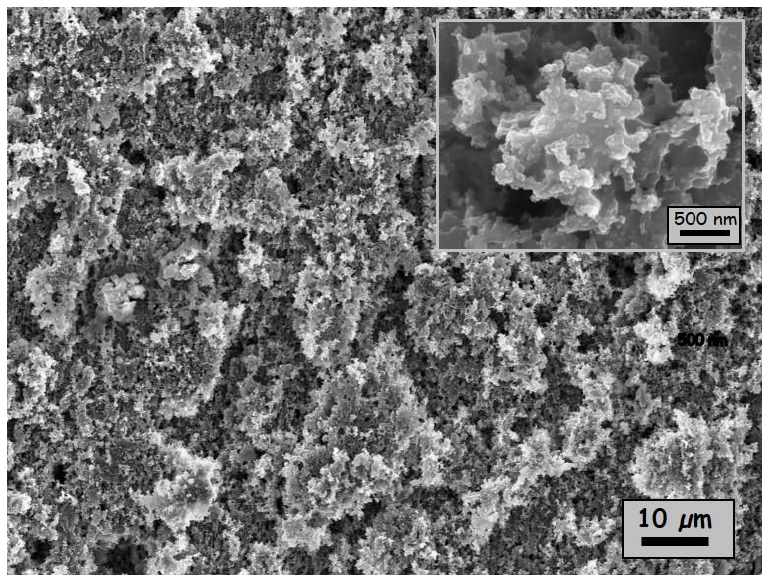
Figure 4. FESEM image of TiO 2 /ns-Al; the inset shows a high-magnification image.